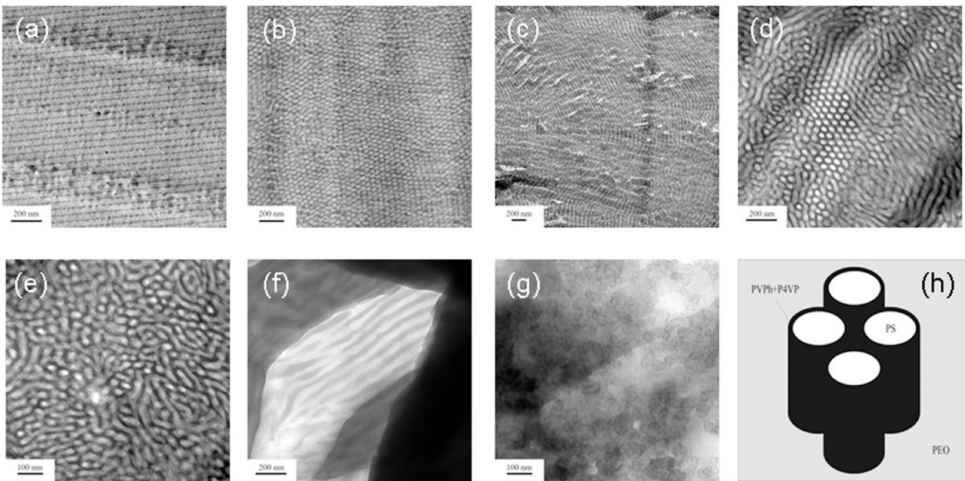
Figure 10. TEM images staining with I 2 of PS- b -PVPh/PEO- b -P4VP mixture at room temperature of ( a ) 100/0, ( b ) 90/10, ( c ) 70/30, ( d ) 50/50, ( e ) 30/70, ( f ) 10/90, ( g ) 0/100, ( h ) cartoon representation of core-shell cylinder structure of PS, PVPh/P4VP, and PEO